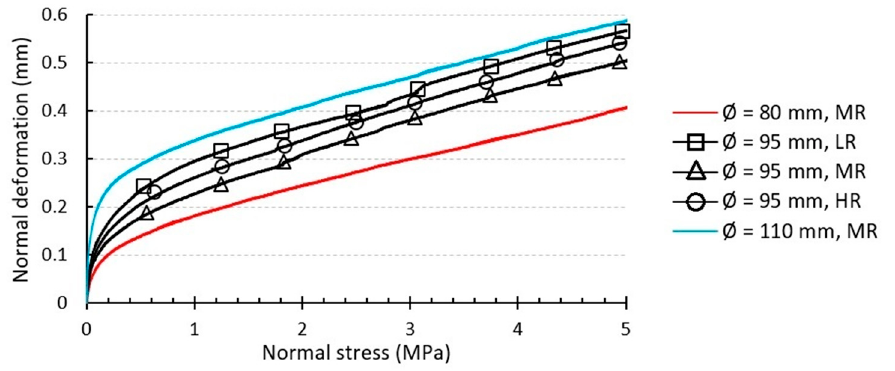
Figure 10. Normal stress-normal deformation curves of J&Br specimens subjected to uniaxial compressive loading. Table 4. Shear stiffness and residual shear strength of J&Br specimens subjected to direct shear test condition. Joint Roughness Diameter (mm)